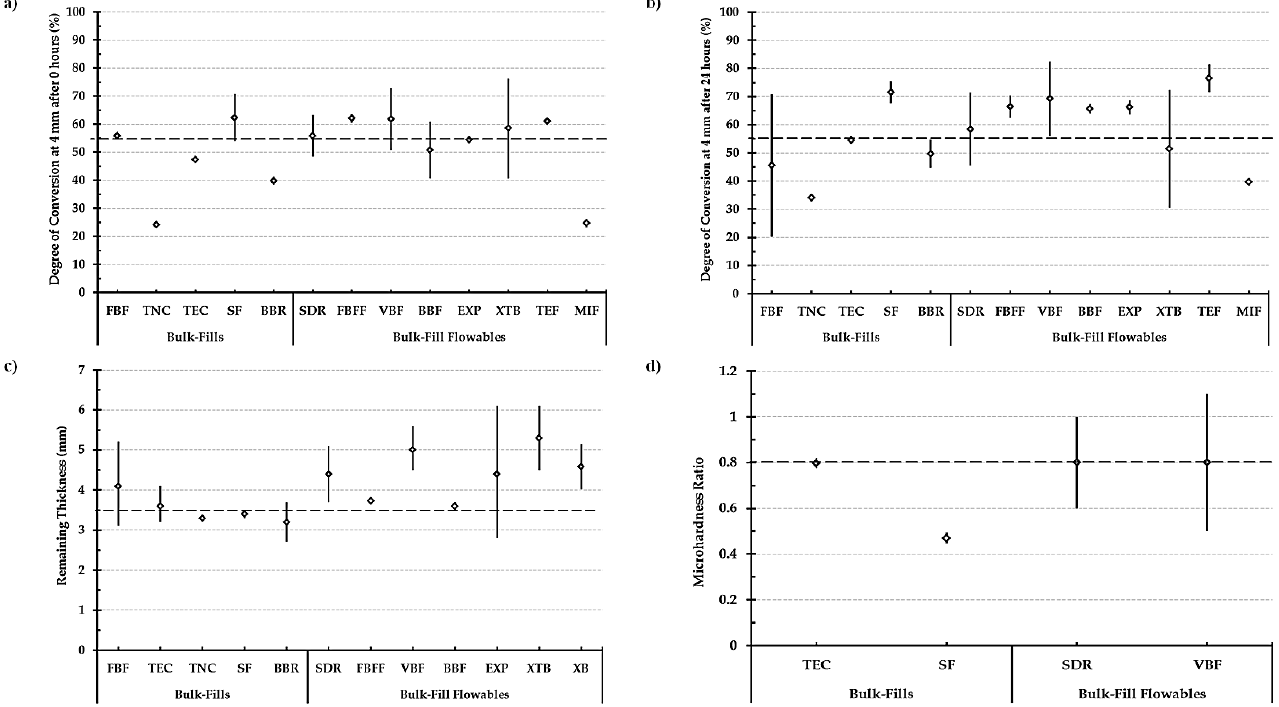
Figure 2. Graphs showing mean values of study parameters from publications reporting means and standard deviations. Summary estimates from relevant meta-analysis were included when performed: ( a ) degree of conversion at 4 mm (0 h after curing), ( b ) degree of conversion at 4 mm (24 h after curing), ( c ) remaining thickness after scrapping method, and ( d ) microhardness ratio at 4 mm (24 h after curing). Diamonds represent means of individual studies or summary estimates of meta-analysis. Black bars represent 95% CI. Dashed line represents acceptable value for the respective parameter. FBF: Filtek Bulk-Fill, TNC: Tetric N-Ceram Bulk Fill, TEC: Tetric Evo-Ceram Bulk-Fill, SF: Sonic Fill, BBR: Beautifil Bulk Restorative, SDR: SureFil SDR, FBFF: Filtek Bulk-Fill Flowable, VBF: Venus Bulk-Fill, BBF: Beautifil Bulk Flow, EXP: Ever-X Posterior, XTB: X-tra Base, TEF: Tetric Evo-Flow Bulk-Fill, MIF: MI Fil, XB: Xenius Base.